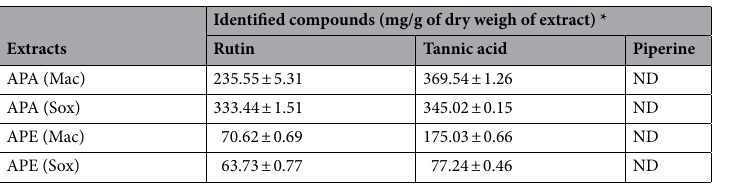
Table 2. Polyphenolic flavonoids and alkaloid content in A. precatorius seed extracts. *Values are means of three replicate samples (n = 3). Data are presented as the mean ± SD. ND; Not Detected.